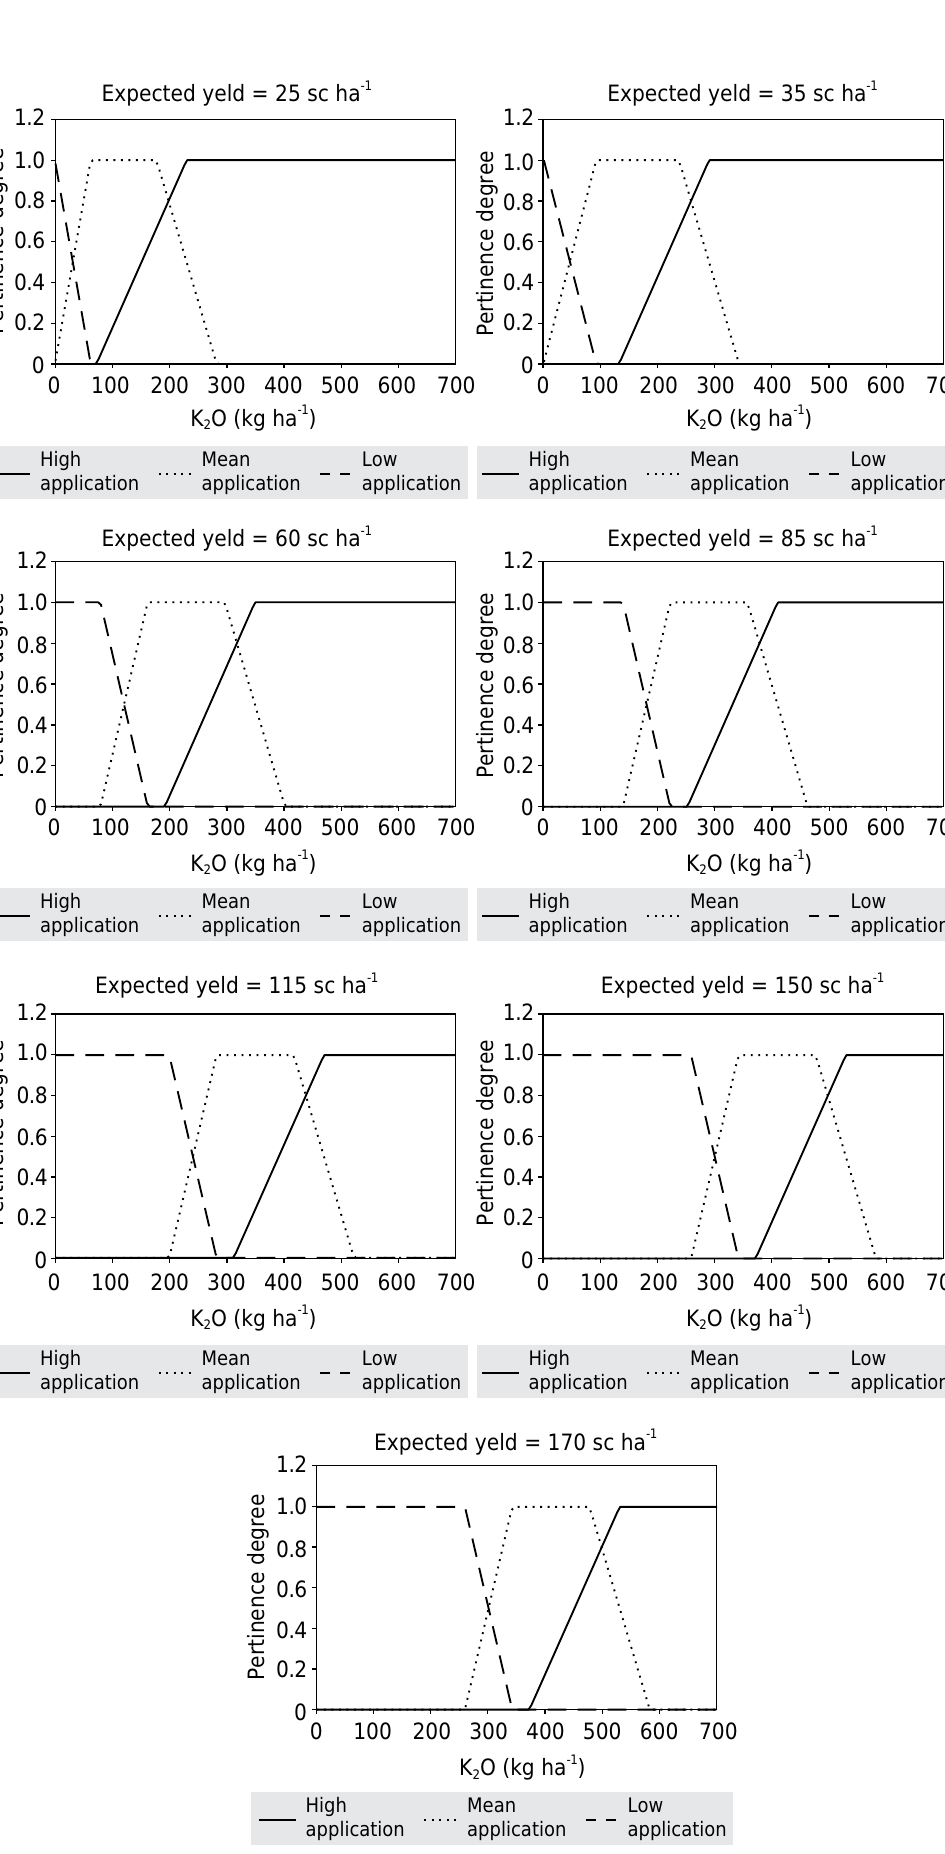
Figure 8. Fuzzy sets for the input variable of potassium application need